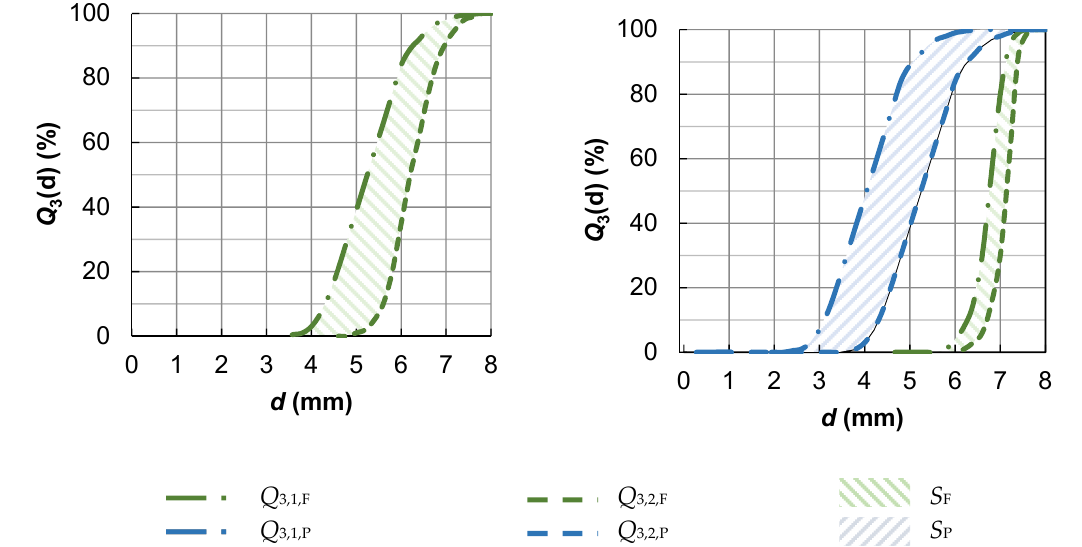
Figure 1. Example of the selectivity S and selective comminution ( SC ) [27], left: selectivity in a feed material; right: shift in selectivity between the feed material (green) and product (blue) due to comminution.